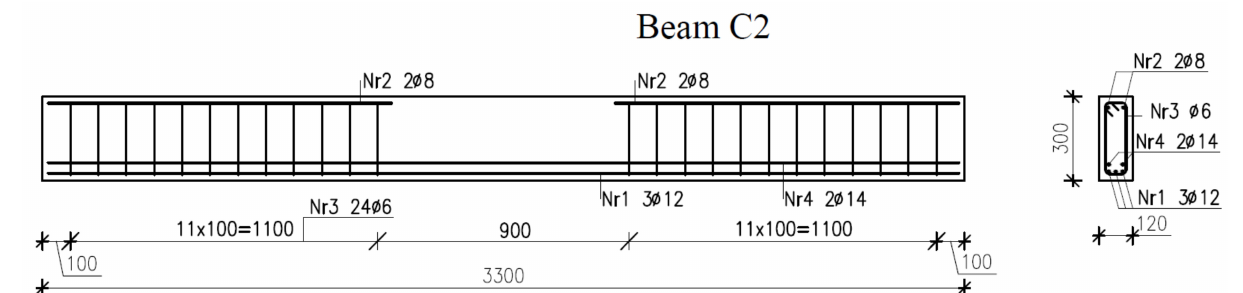
Figure 3. Reinforcement in beams D2.